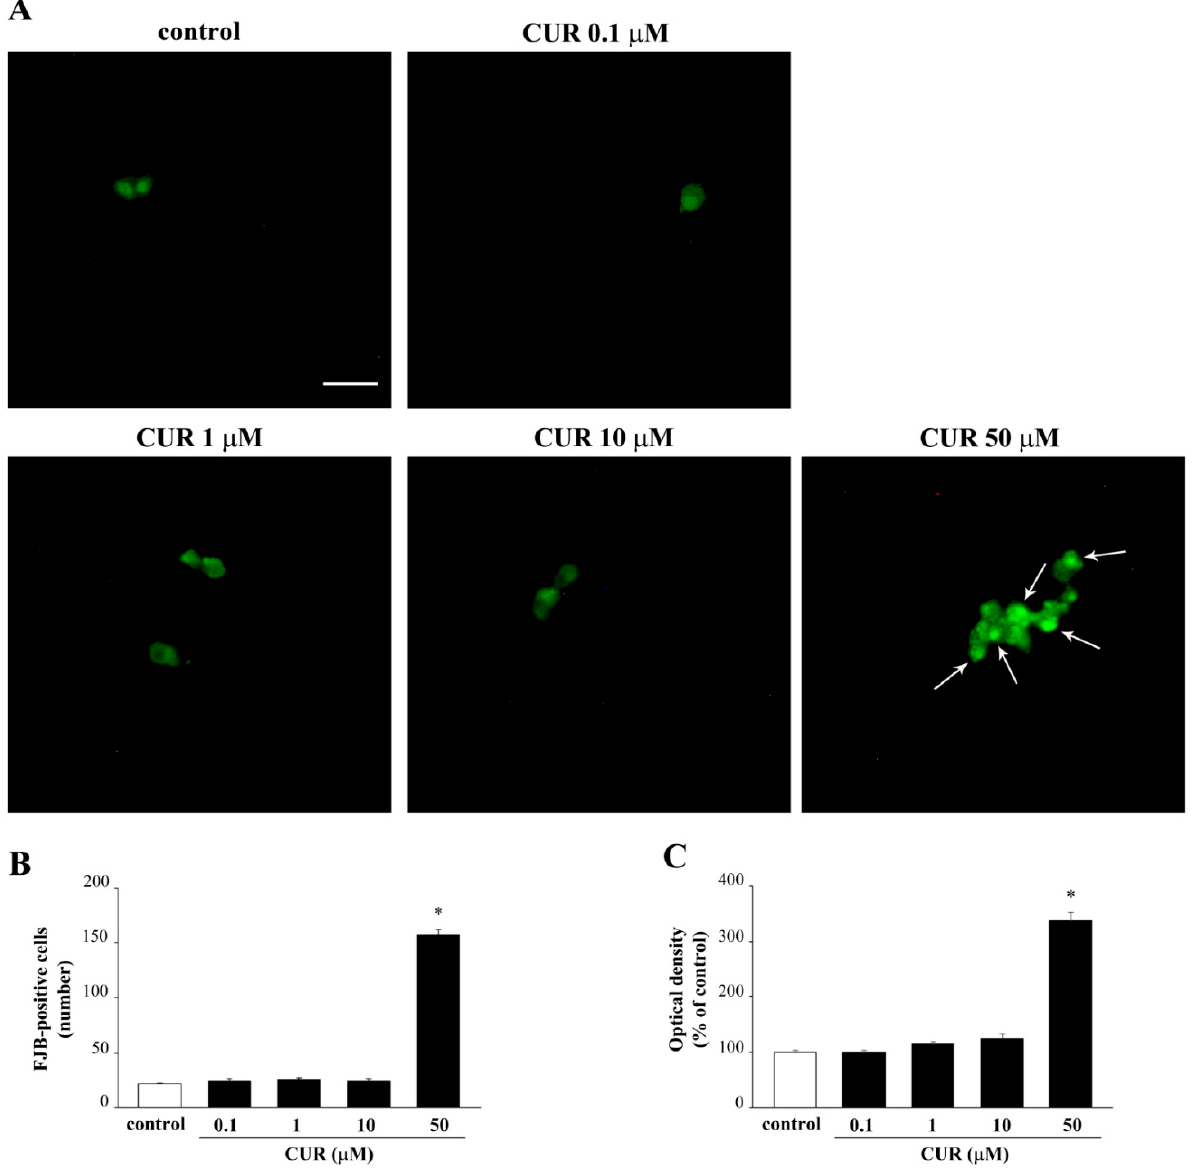
Figure 2. FJB-responsive PC12 cells after increasing doses of CUR. ( A ) Representative pictures of FJB-stained PC12 cells after CUR administration ranging from 0.1 µ M up to 50 µ M for 72 h. The graphs ( B , C ) report the number and the intensity of FJB fluorescent cells, respectively. Arrows indicate FJB intensely positive cells. * p ≤ 0.05 compared with control. Scale bar = 17.5 µ M.